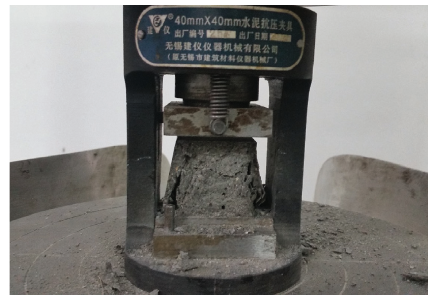
Figure 2: Compressive strength testing.